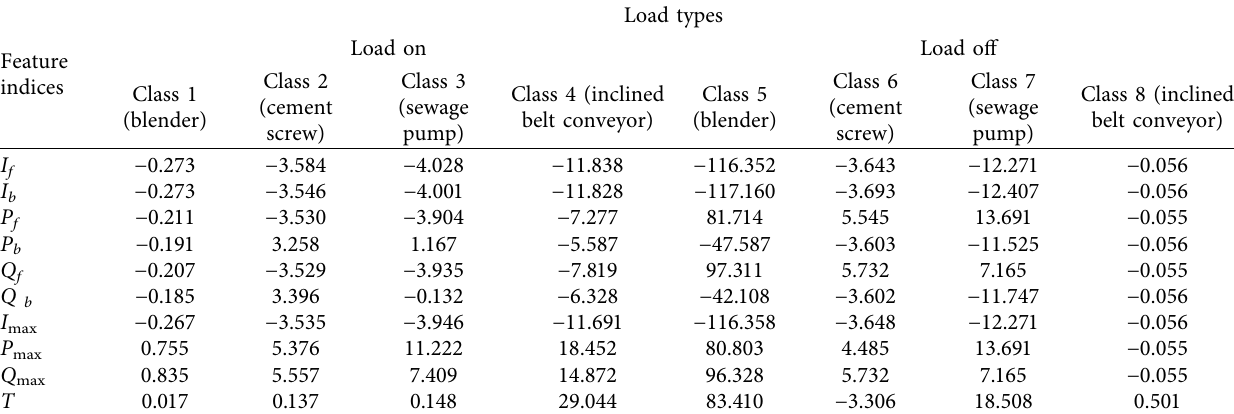
Table 10: Cluster centres for the transient